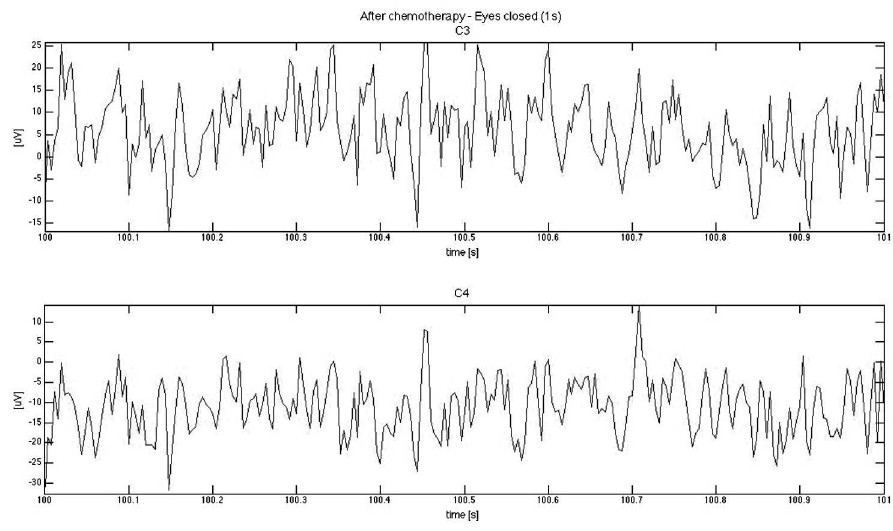
Figure 6. Eyes closed (1 random second), C3 (top) and C4 (bottom), typical strong Alpha waves